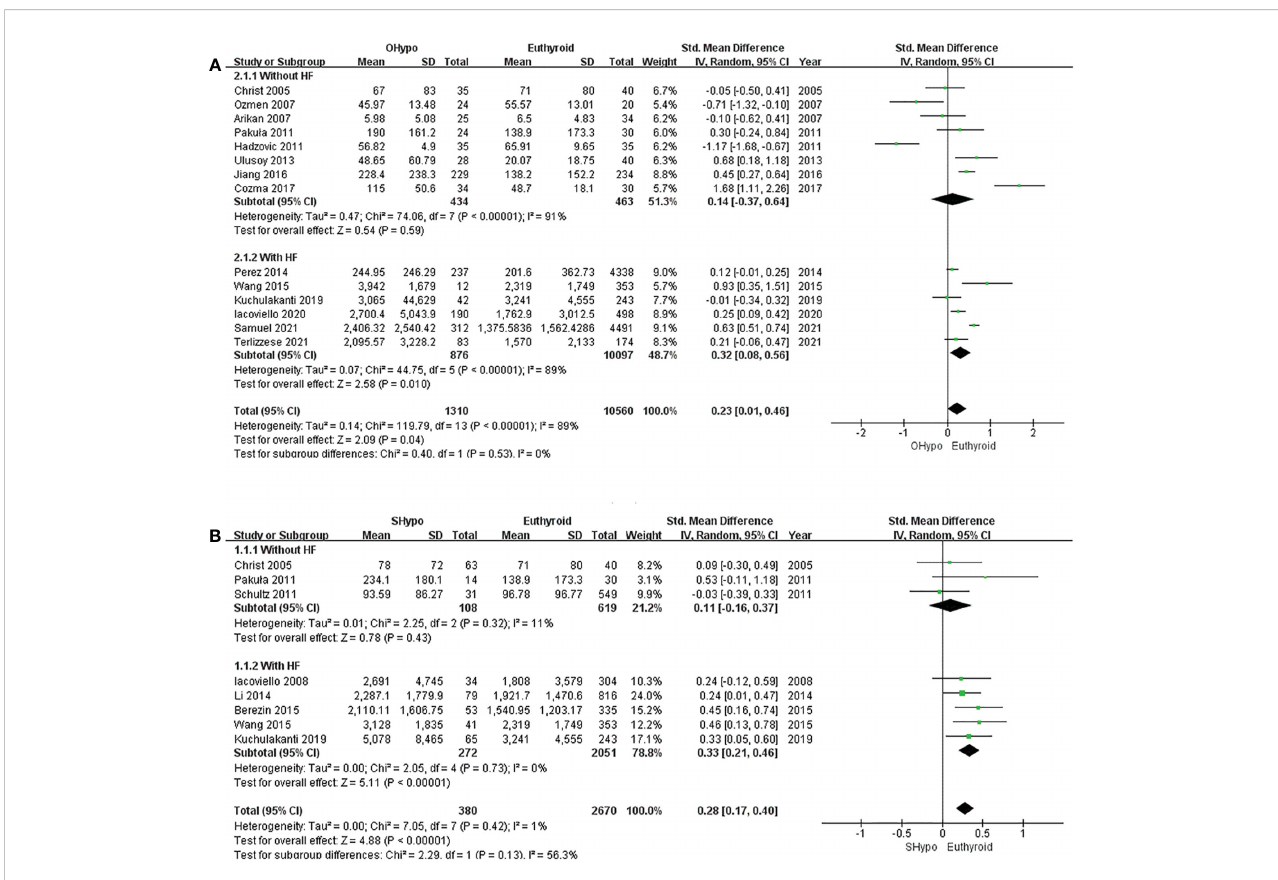
FIGURE 3 Forest plot of the NT-proBNP levels in patients with (A) OHypo and euthyroid subjects; (B) SHypo and euthyroid subjects.